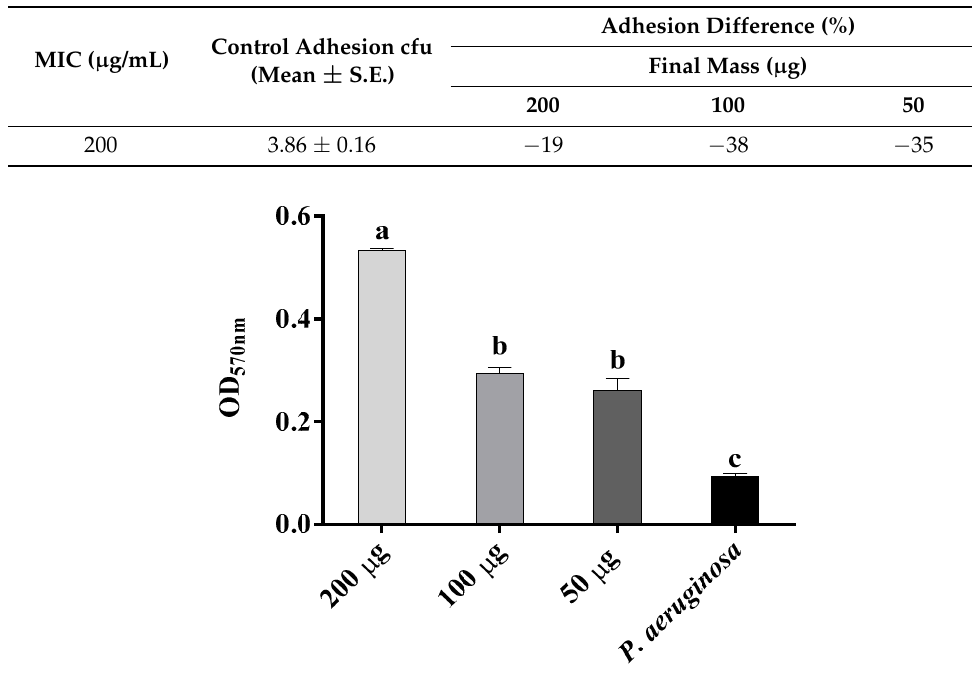
Figure 5. Biofilm formation of Pseudomonas aeruginosa in the presence of 200 µg, 100 µg, and 50 µg (final mass) of 3,4 ′ ,5,7-tetrahydroxyflavanone from kino exudate of Corymbia torelliana . Optical densities at 570 nm wavelength (OD 570nm ) are presented as mean + S.E. Means with different letters are significantly different (ANOVA and Tukey’s HSD test; p < 0.05; n = 3).